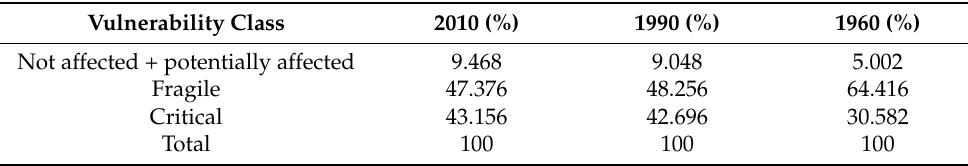
Table 2. Spatial partition of land vulnerability macro-classes by year.